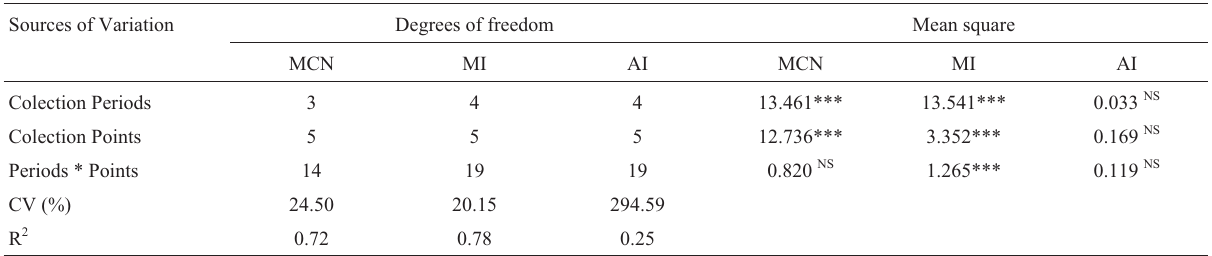
Table 6 - Sources of variation, degrees of freedom, and mean square of micronuclei (MCN) number in Astyanax altiparanae , in addition to the MI and AI reported in Allium cepa. Sources of